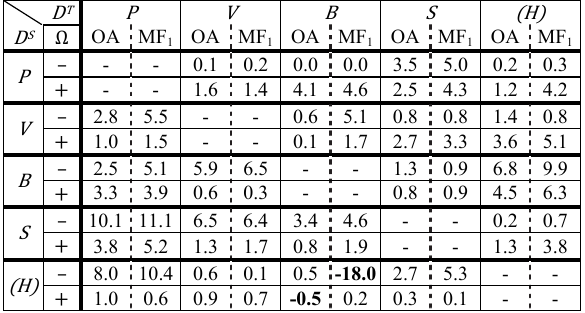
Table 4: Improvements in (cid:4670)%(cid:4671) , achieved by adapting M S,Ω to D T . Adapting the models initially trained using strong augmentation leads to a positive transfer in 19 out of 20 cases with an average improvement of 1.8% in overall accuracy and 2.6% in MF 1 .